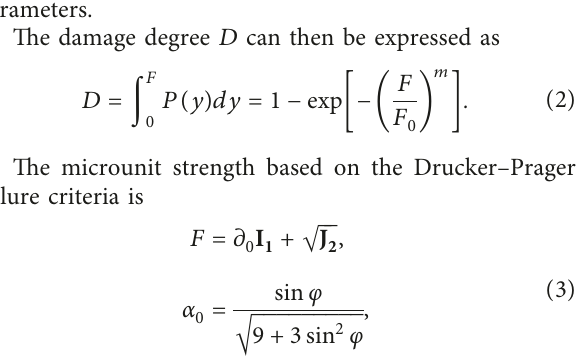
Figure 5: Dependence of the compressive stress on the